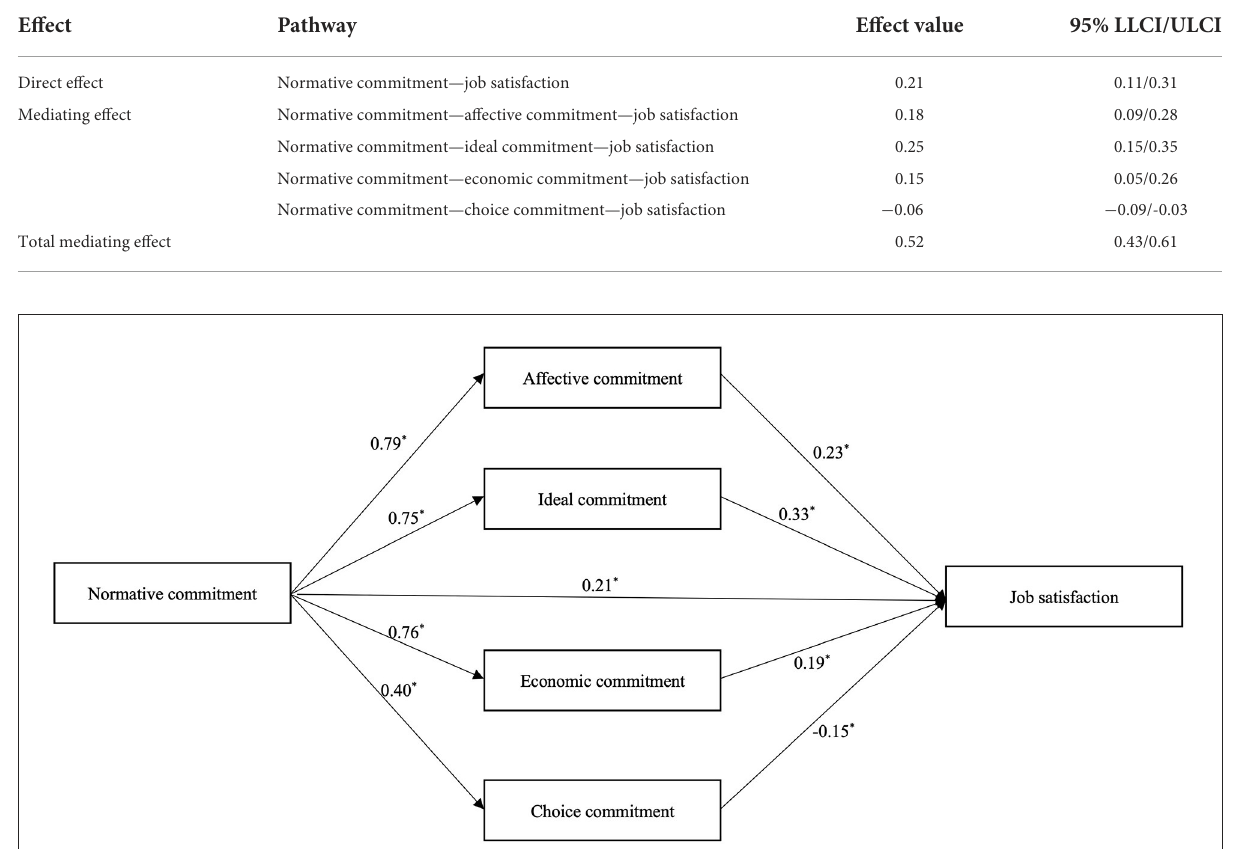
commitment on job satisfaction was significant (LLCI = 0.11, ULCI = 0.31), and the mediators identified a partial mediating effect instead of a total mediating